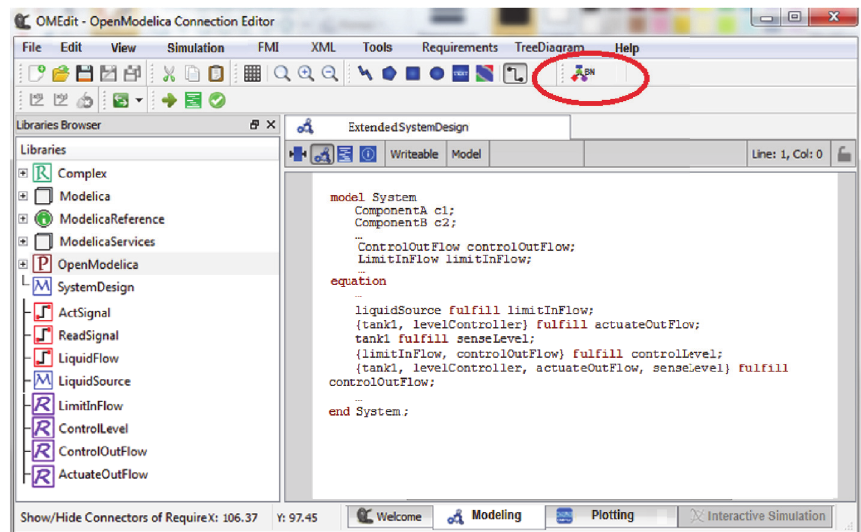
Figure 6: OpenModelica prototype with Modelica language extended for supporting BN